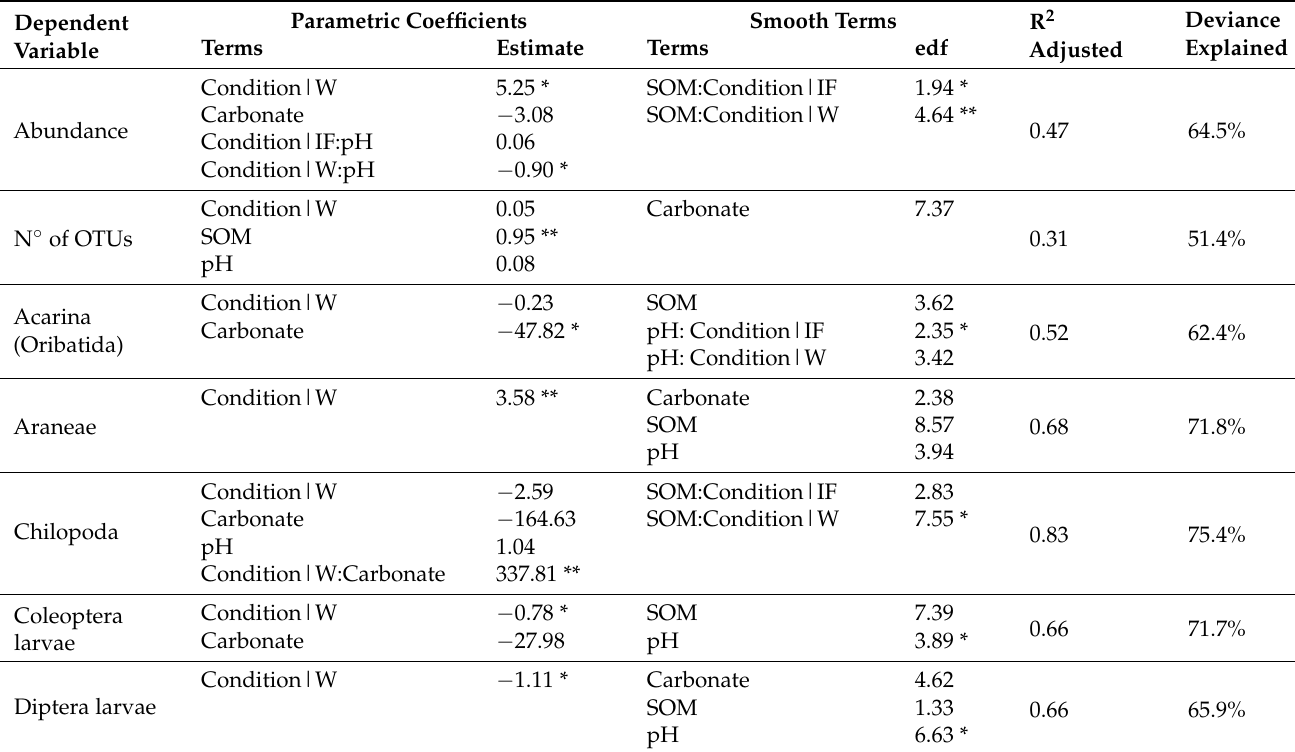
Table 2. Generalized additive model (GAM) results for total arthropod abundance variation, number of out, and OTU selected from the FAMD. edf = effective degrees of freedom. Asterisks mean: * p ≤ 0.05, ** p ≤